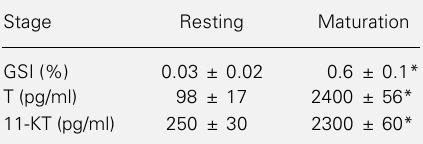
Table 1 - Plasma testosterone (T) and 11-ketotes- tosterone (11-KT) levels during the resting and maturation stages of the gonadal cycle. Data are reported as means ± SEM for 15 fish in each group. GSI = (gonad weight/body weight)